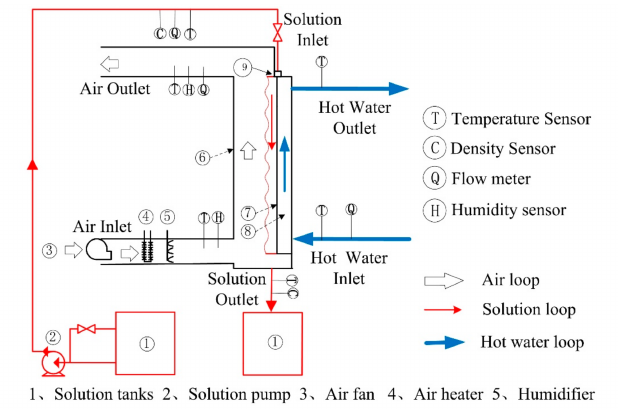
Figure 2. Schematic diagram of the test